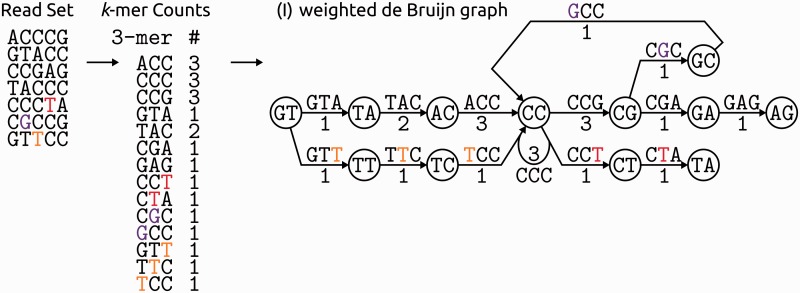
Example of a weighted de Bruijn graph from the example read set. The read set is augmented to include reads that show variation compared to the example read set in the earlier figures: while the Ts (red and orange) could be substitution errors and the G (purple) could be an insertion error, all three could also be reads covering alternative alleles of the same sequence locus or slightly different repeats at other sequence loci. The new reads create graph structures that are commonly removed in graph pruning (and thus correction) steps: (i) the orange T creates a bulge, a cycle in the graph that can not be traversed by a single path, as edges of the cycle go in opposing directions (e.g. edges ACC and TCC both ending at node CC); (ii) the red T creates a tip, a short dead end of the graph; (iii) the purple G creates a whirl, a cycle in the graph with a possible path going around the whole cycle (i.e. all edges go in the same direction). A repeat graph would have small (and assumingly erroneous) whirls, bulges and tips removed and repeats collapsed, but care must be taken to not remove genuine variation. A colour version of this figure is available at BIB online: http://bib.oxfordjournals.org.